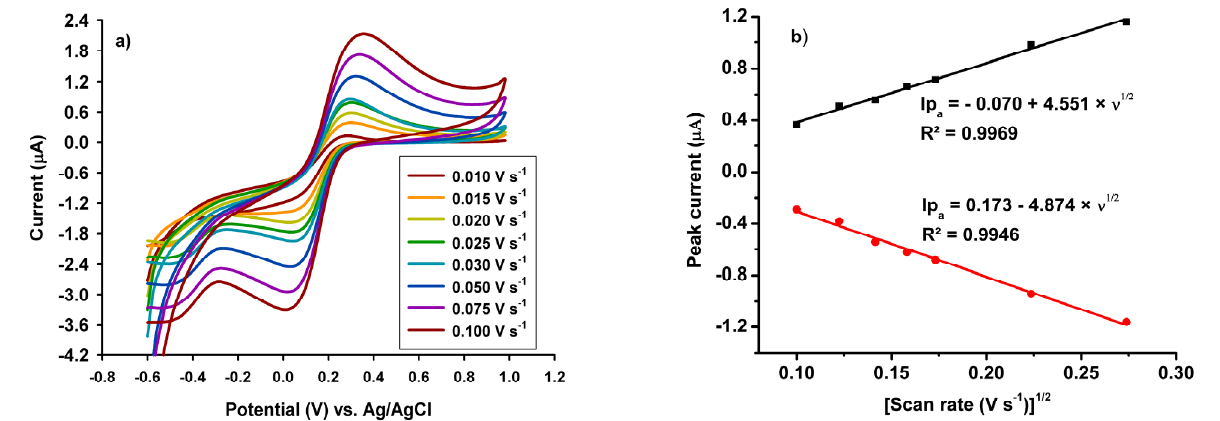
Figure 3. ( a ) Cyclic voltammograms in a solution of 5.0 × 10 − 3 mol L − 1 K 3 [Fe(CN) 6 ] (0.1 mol L − 1 KCl) at different scan rates from 0.010 to 0.100 V s − 1 using the Fe(TPFPP)Cl/AuNPs-S-Gr sensor (working conditions: potential range from − 0.6 to 1.0 V; step potential 0.025 V). ( b ) Dependence of the peak current on the square root of the scan rate, using the Fe(TPFPP)Cl/AuNPs-S-Gr sensor.